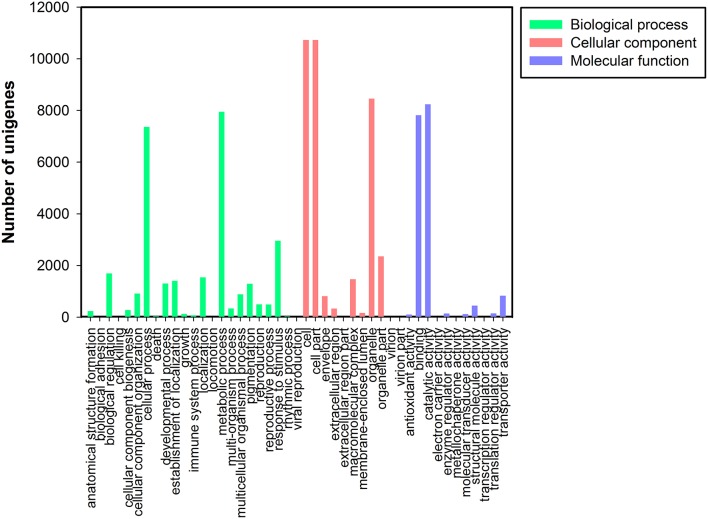
Gene Ontology classification of assembled unigenes. Total 16,671 unigenes were categorized into three main categories: biological process, cellular component, and molecular function.